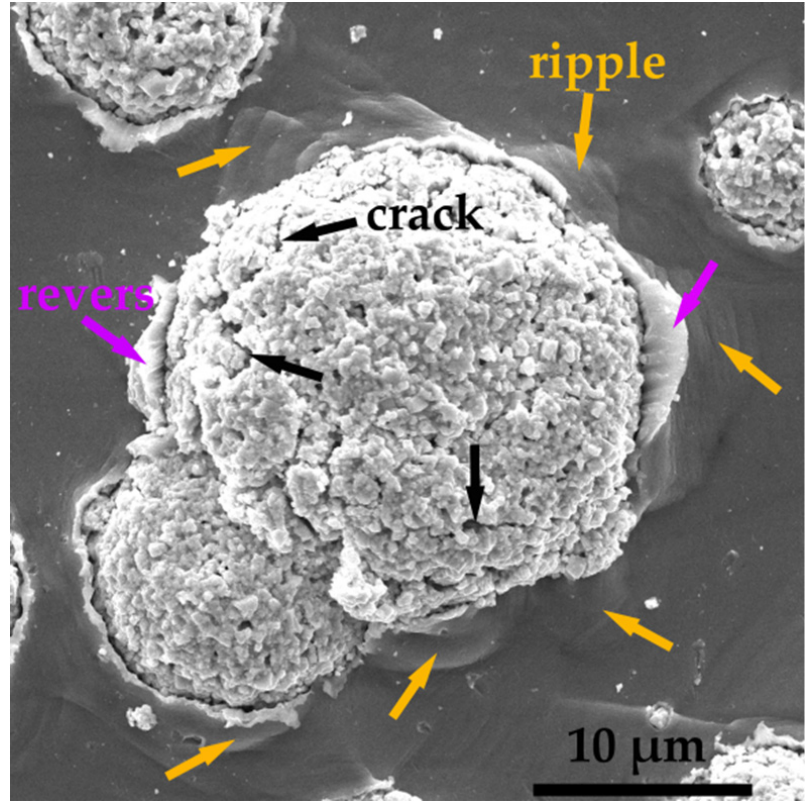
Figure 8. Surface morphologies of different size WC-17Co splats deposited by cold spraying.